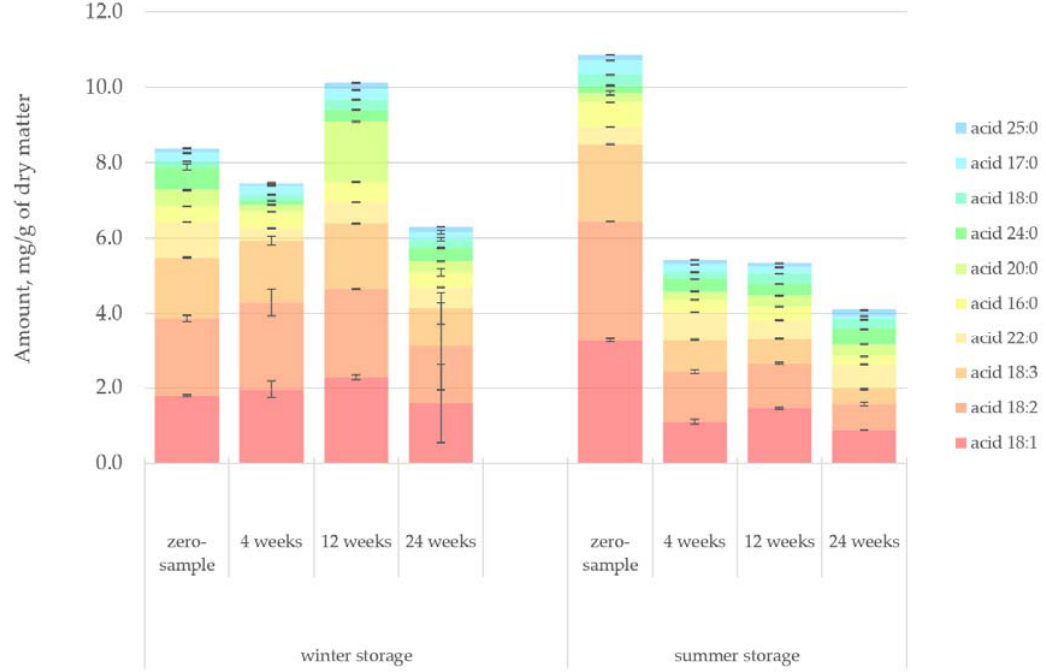
Figure 7. Changes in fatty acids during summer and winter storage periods of saw log bark.